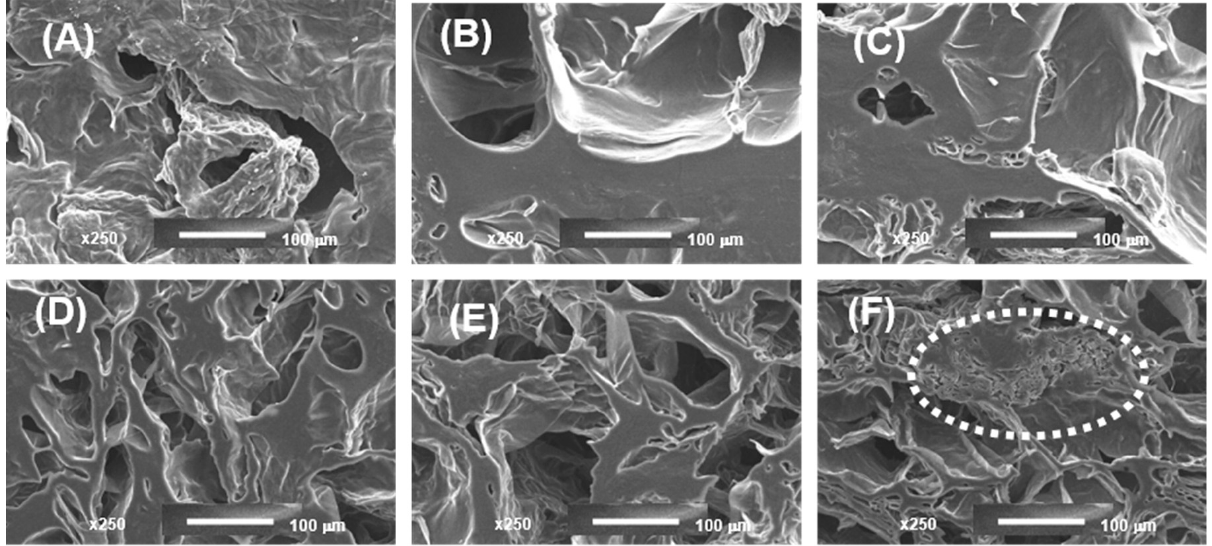
Figure 7. Scanning electron micrographs of the 3D-printed gel containing LA14 ( A – C ) and LA16 ( D – F ) callus. The content of callus in the ink was 33 ( A , D ), 50 ( B , E ), and 66 g/100 mL ( C , F ). Magnification 250×; scale bar 100 μ m. The area of dense folded formation is outlined by a dotted line.